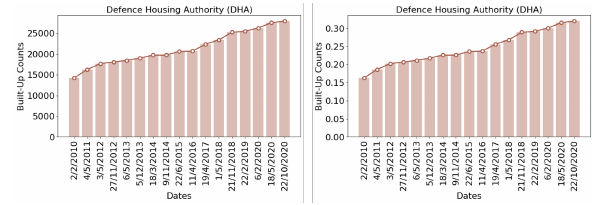
Figure 9. Urban Sprawl in DHA: The results of building counts (left) and built-up ratios (BRs) (right) with x-axis representing the date (dd/mm/yyyy